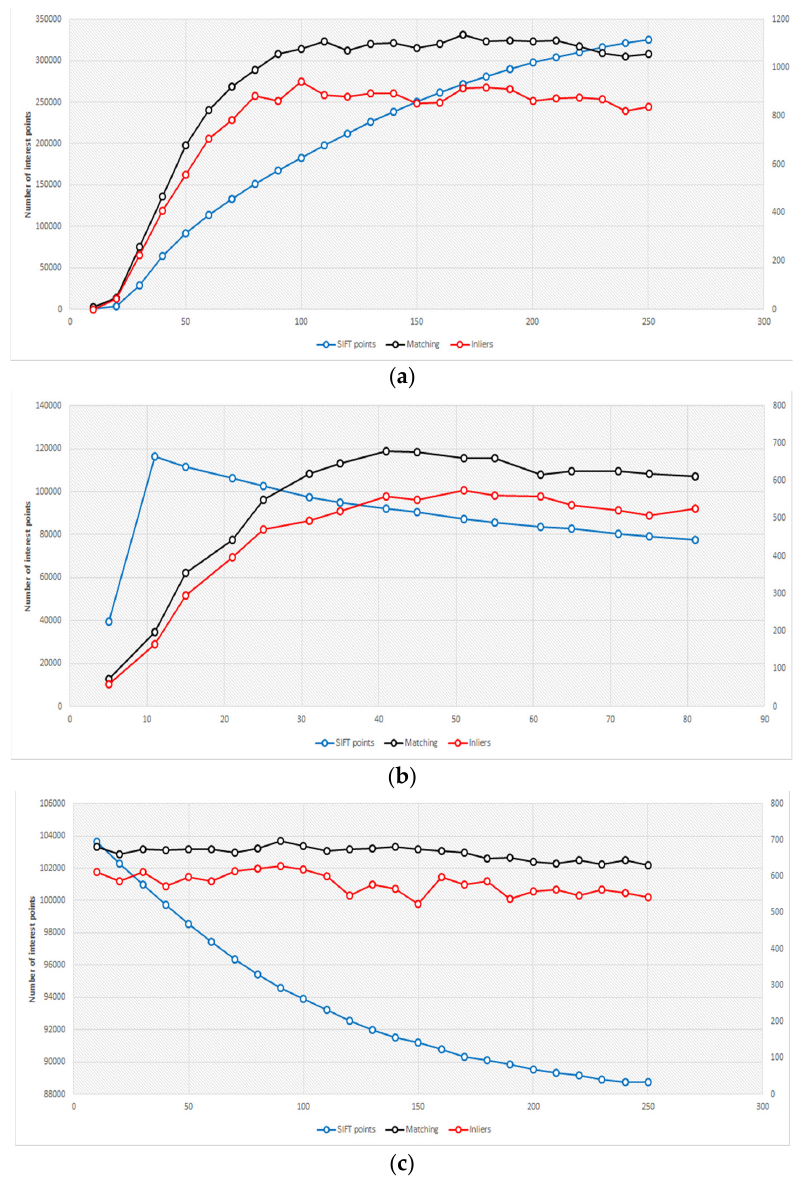
Figure 8. Results of the Wallis evaluation on the cross vault dataset. The charts report the number of extracted interest points with respect to the considered parameter values: ( a ) cross vault dataset—performance evaluation varying the standard deviation; ( b ) cross vault dataset—performance evaluation varying the window size; and ( c ) cross vault dataset—performance evaluation varying the mean.